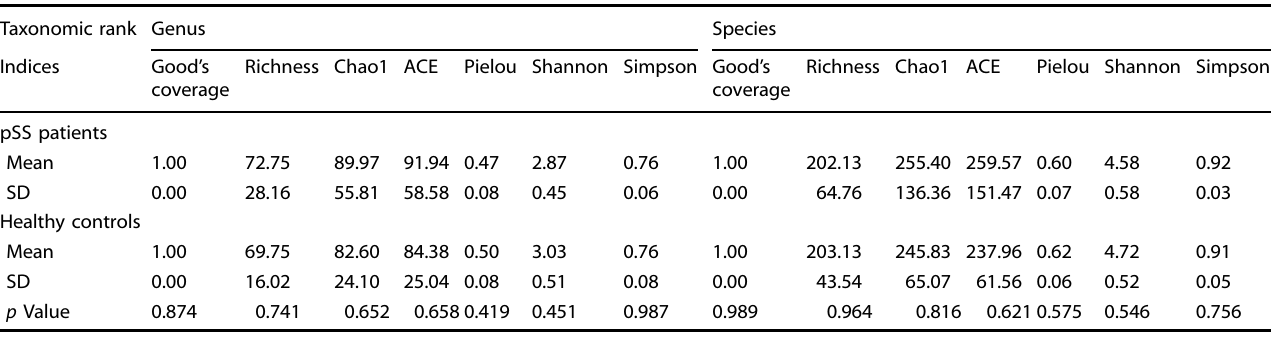
Table 2. Alpha diversity at the genus and species